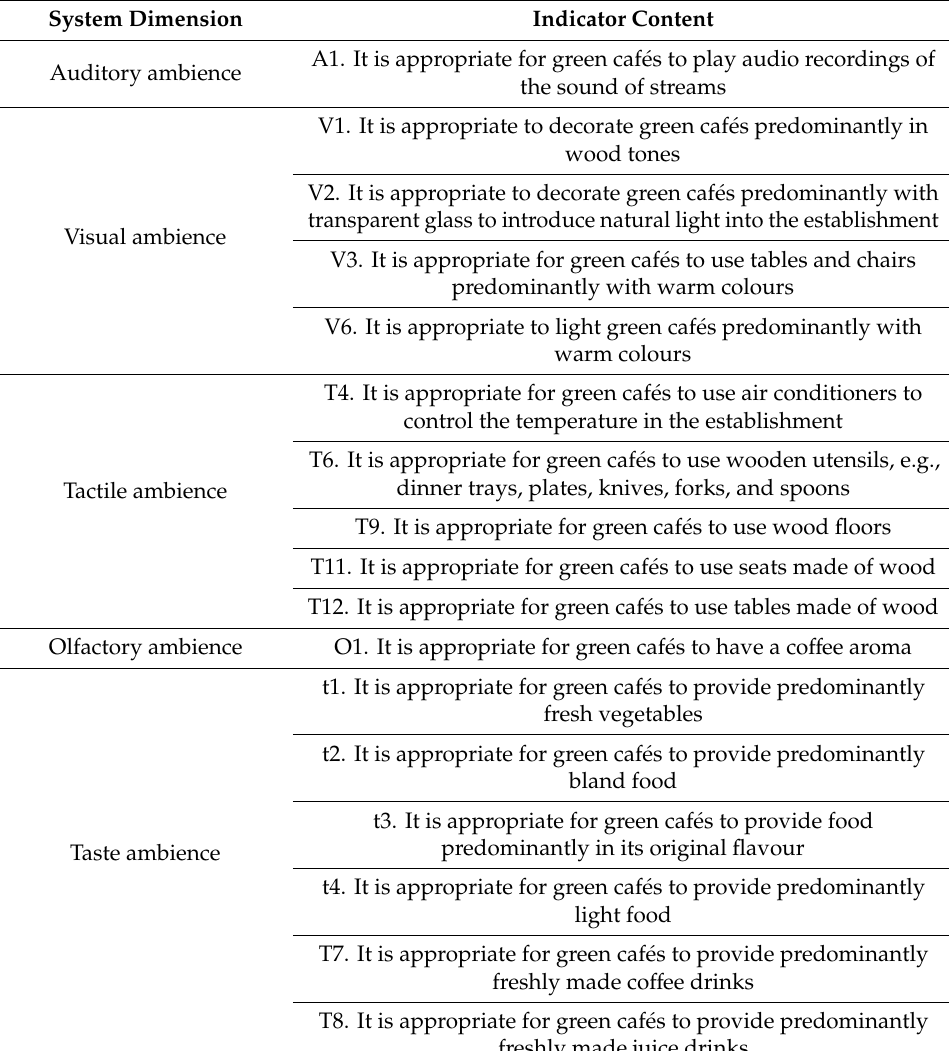
Table 4. Selected indicators in this study for verification with actual caf é